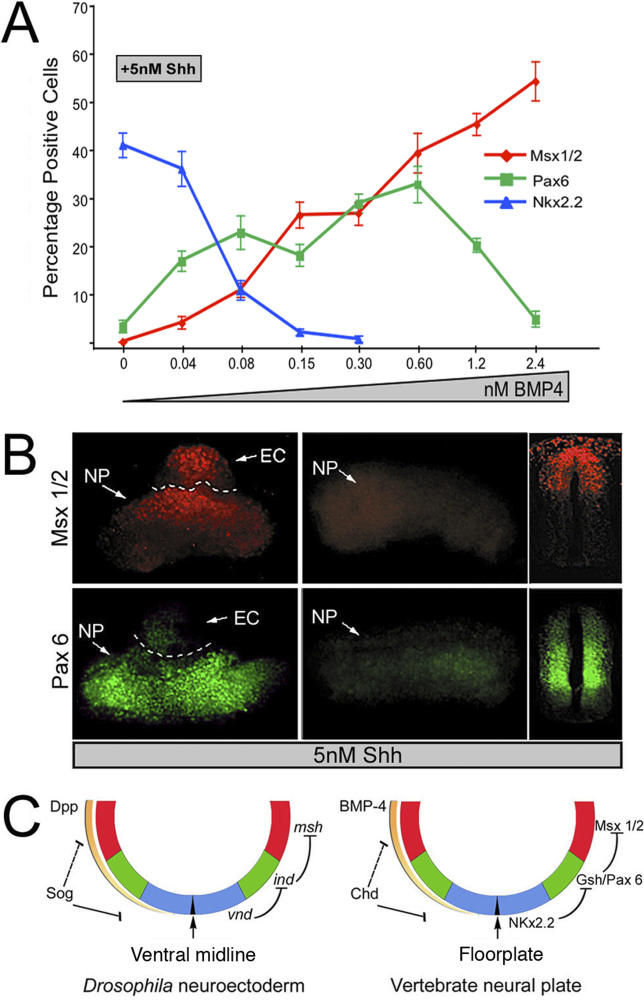
Dose-Dependent BMP-Mediated Repression in Neural Plate Explants(A) Chick intermediate neural plate explants were grown in 5 nM Shh and a range of BMP4 from 0 nM to 2.4 nM. Cells were stained with antibodies for Nkx2.2, Pax6, or Msx1/2 and number of positive cells per explant was counted and the percentage of positive cells was calculated and graphed. Error bars indicate standard error of the mean. The number of explants assayed was as follows, starting at 0 nM and ending at 2.4 nM BMP4: Nkx2.2 (25, 12, 15, 18, 12), Pax6 (18, 6, 18, 24, 30, 12, 24, 28), and Msx1/2 (12, 6, 16, 11, 17, 11, 17, 17).(B) Intermediate chick neural plate explants (NP) with (left) or without (right) BMP-expressing non-neural ectodermal tissue (EC) placed on the top edge, and cultured in the presence of 5 nM Shh. The fraction of Msx1/2-expressing cells is highest near the BMP source (top, left), and diminishes as a function of distance from the ectoderm. In a separate neural plate/ectoderm co-culture (bottom, left), Pax6 is expressed at a greater distance from the ectoderm, but not in nearby neural plate cells, which presumably express Msx1/2. These results mimic the relative expression domains of Msx1/2 and Pax6 in a stage 20 chick neural tube (far right).(C) Simplified summary model indicating the proposed similarities in BMP-mediated patterning of the vertebrate and invertebrate neuroectoderm. Two processes collaborate to establish the pattern of neural identity gene expression in Drosophila and vertebrates: graded BMP signaling preferentially represses expression of ventral neural identity genes (left), which then engage in a chain of ventral-dominant repression wherein more ventral genes prevail in repressing the expression of more dorsal genes (right). The indicated inhibition of Msx1/2 by Pax6 remains hypothetical. Not indicated on this scheme are additional levels of cross-inhibition (e.g., Vnd inhibition of msh, late Ind repression of vnd, and Pax6 repression of Nkx2.2) [9,10,16,21,61,62], which are likely to help sharpen and refine the pattern created by the core mechanism of threshold-dependent BMP repression coupled to ventral dominance.